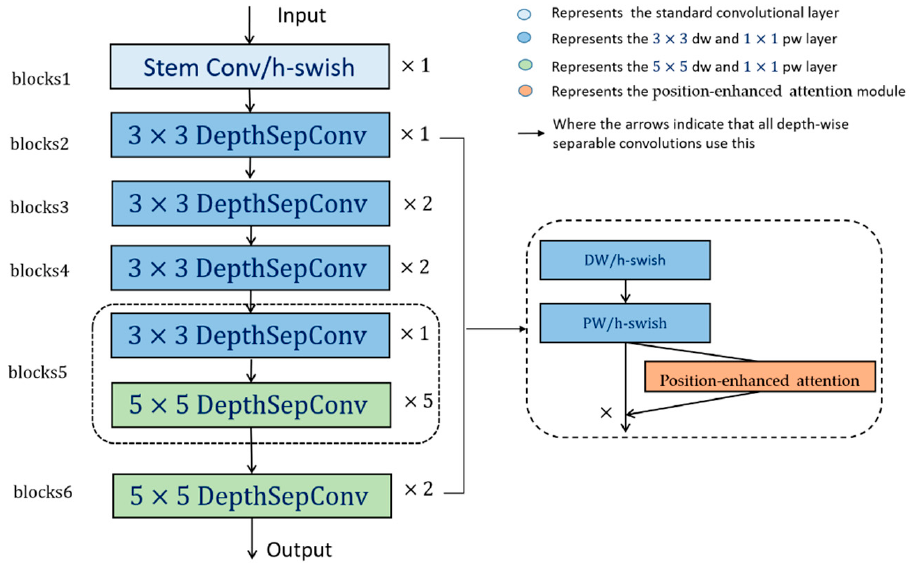
Figure 2. The details of the NLCNet backbone